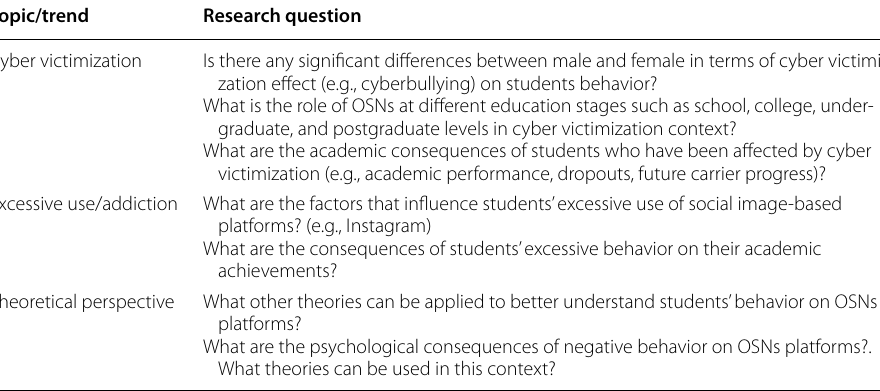
Table 7 Research agenda for understanding students’